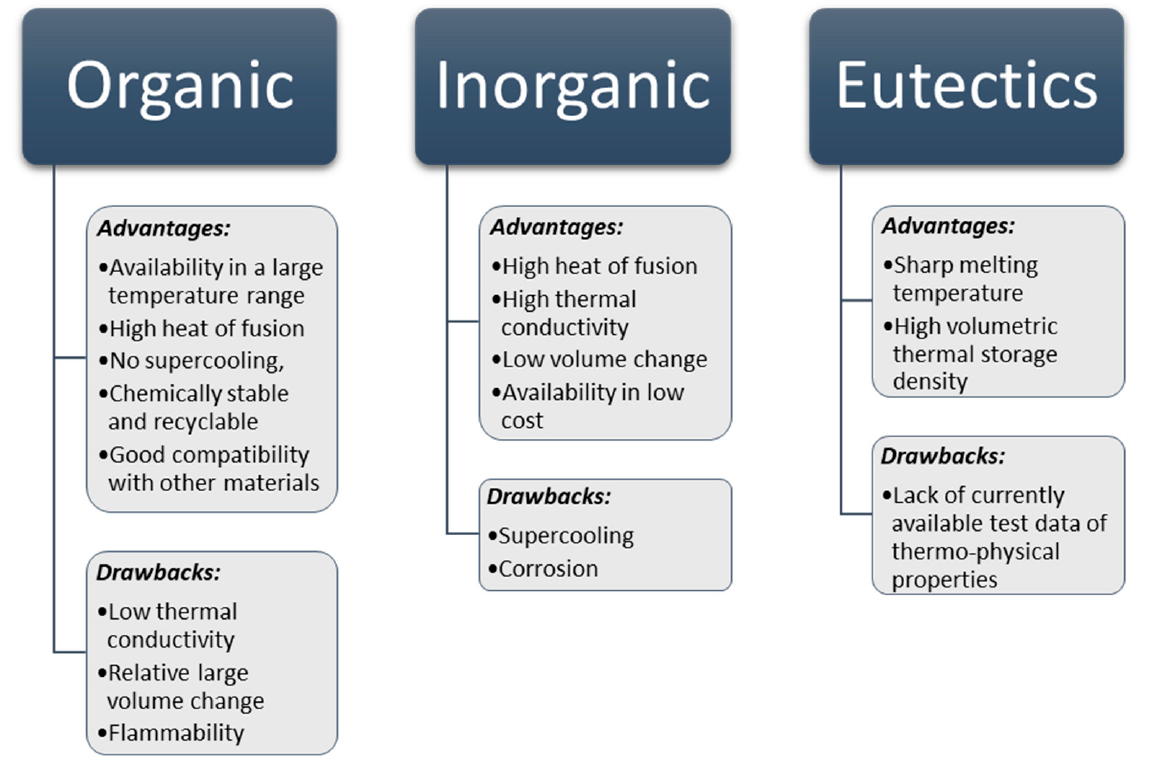
Figure 2. Advantages and drawbacks of PCMs.